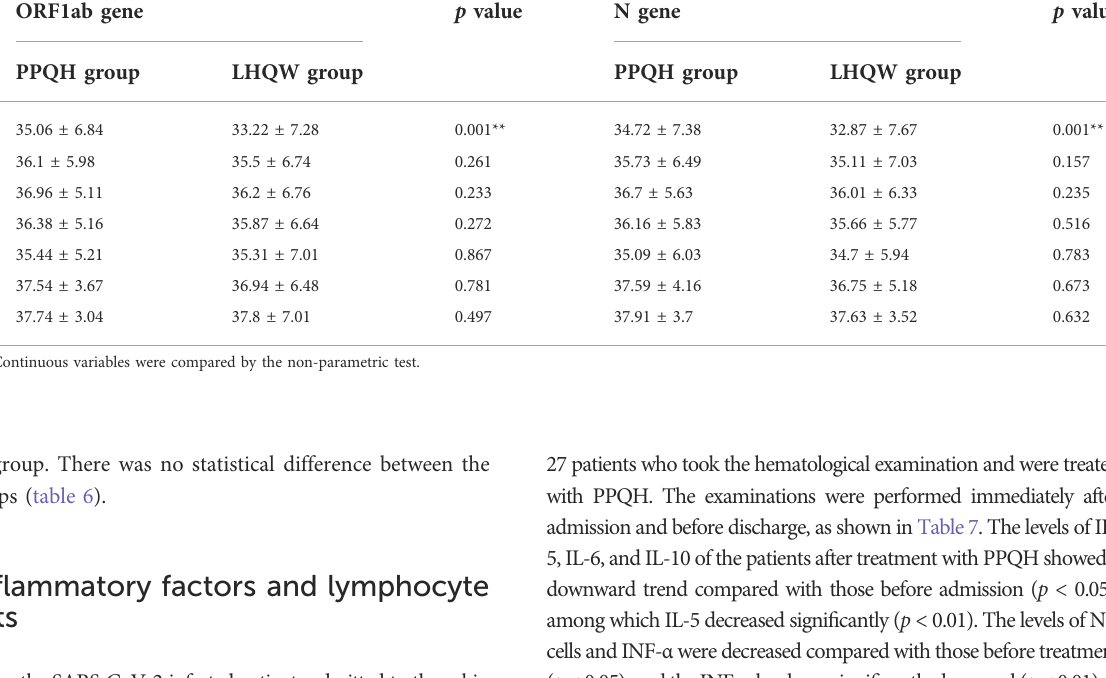
TABLE 3 Comparison of the Ct valuesof the ORF1ab and N gene between the two groups of SARS-CoV-2-infected patients (x ±s). **p < 0.01. (X is the average value, i.e. X bar, and a horizontal line should be added at the top of X. ORF1ab gene p value N gene p value PPQH group LHQW group PPQH group LHQW